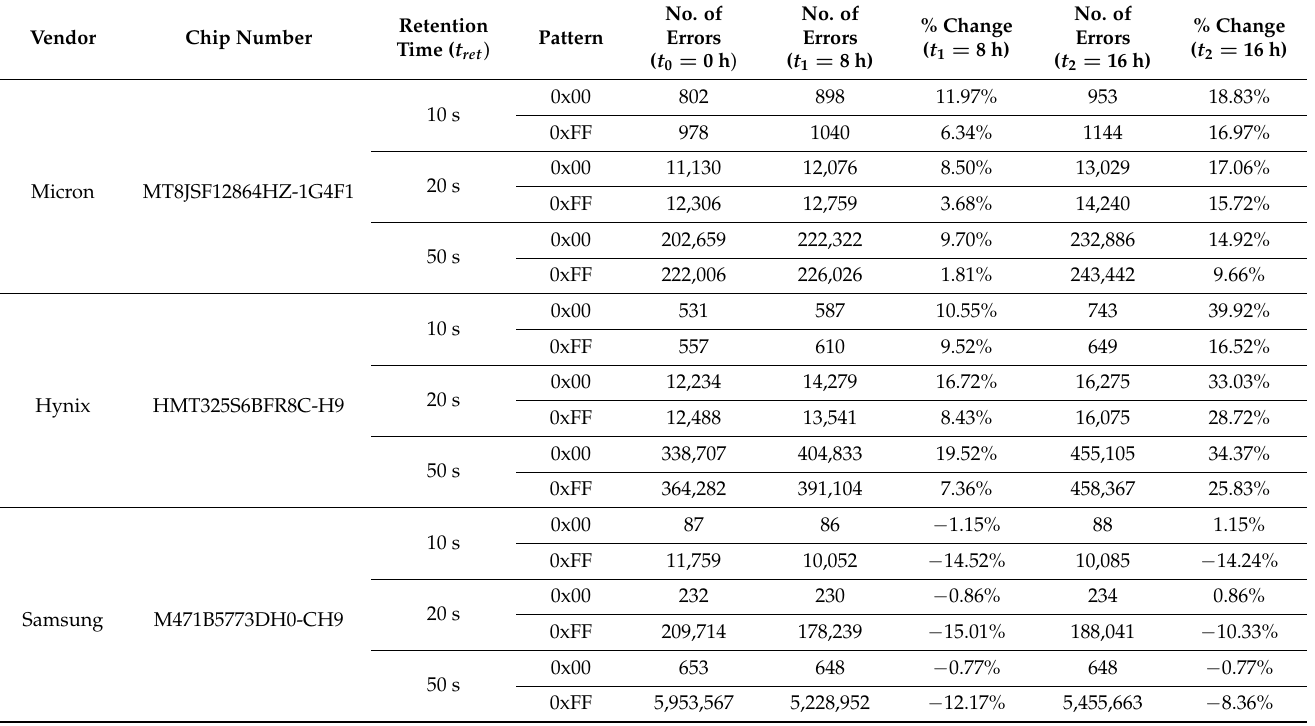
Table 1. Summary of retention error for sample DRAM